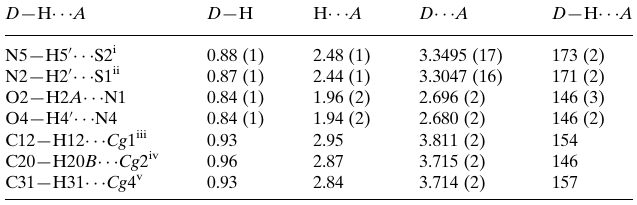
Hydrogen-bond geometry (A˚ , (cid:3)